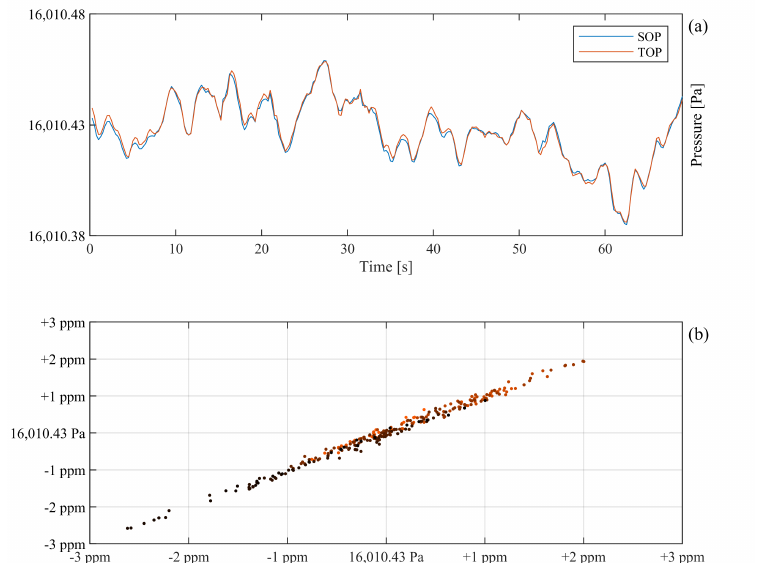
Figure 8. ( a ) An enlargement of 70 s of the refractometry data shown in the first cycle of Figure 7. ( b ) A correlation plot of the same data. The x and the y -axes represent the pressures assessed by the SOP and the TOP, respectively. In the latter, time is represented by the color, where the first data points are marked with orange and the last ones are in black.